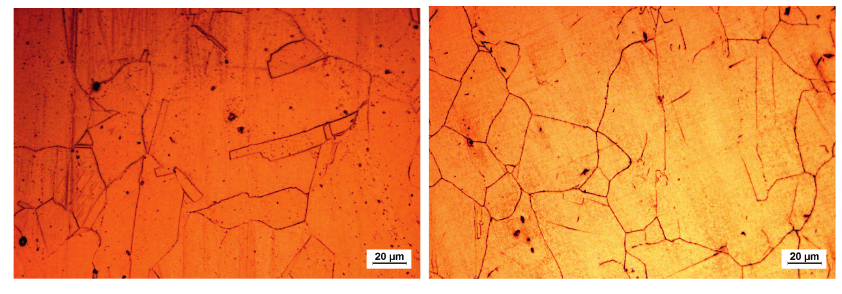
Figure 8: Optical micrograph: Steel 1.4841 (longitudinal section of the speci- men), 4% natal: (a) as-received material and (b) after creep process performed at 823 K/167 MPa/1,200